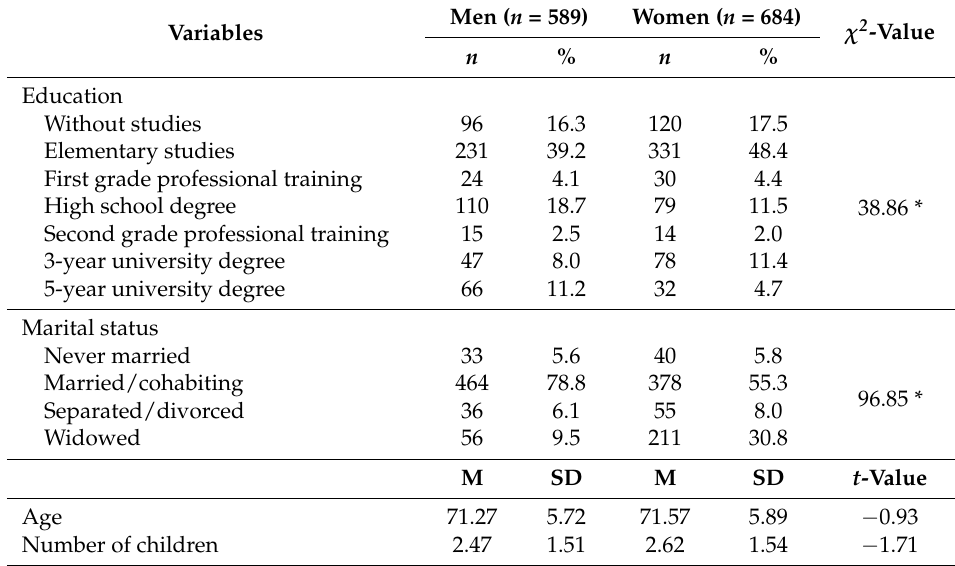
Table 1. Demographic characteristics of the male and female